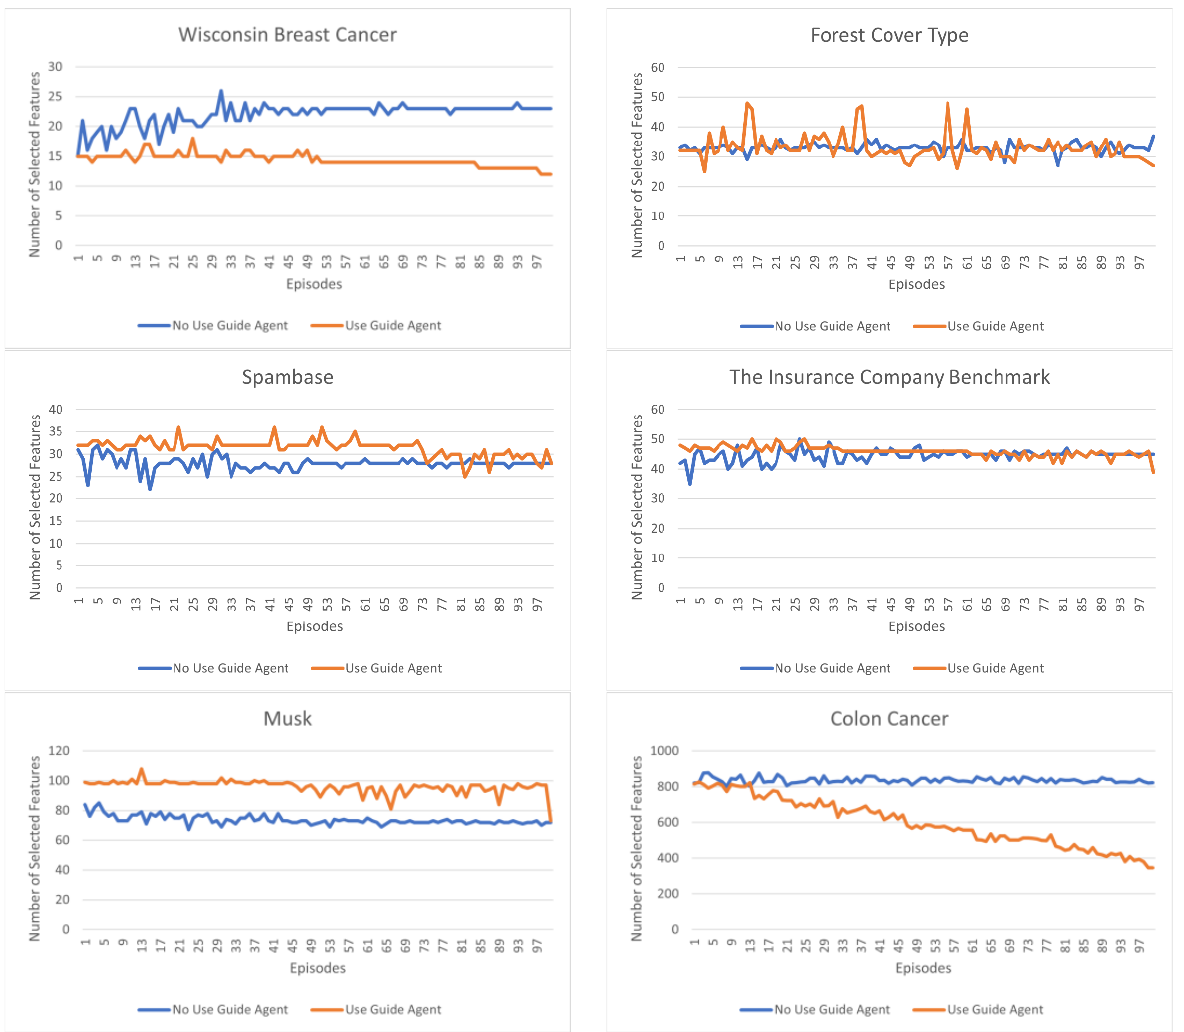
Figure 5. Number of selected features per episode, for each dataset.